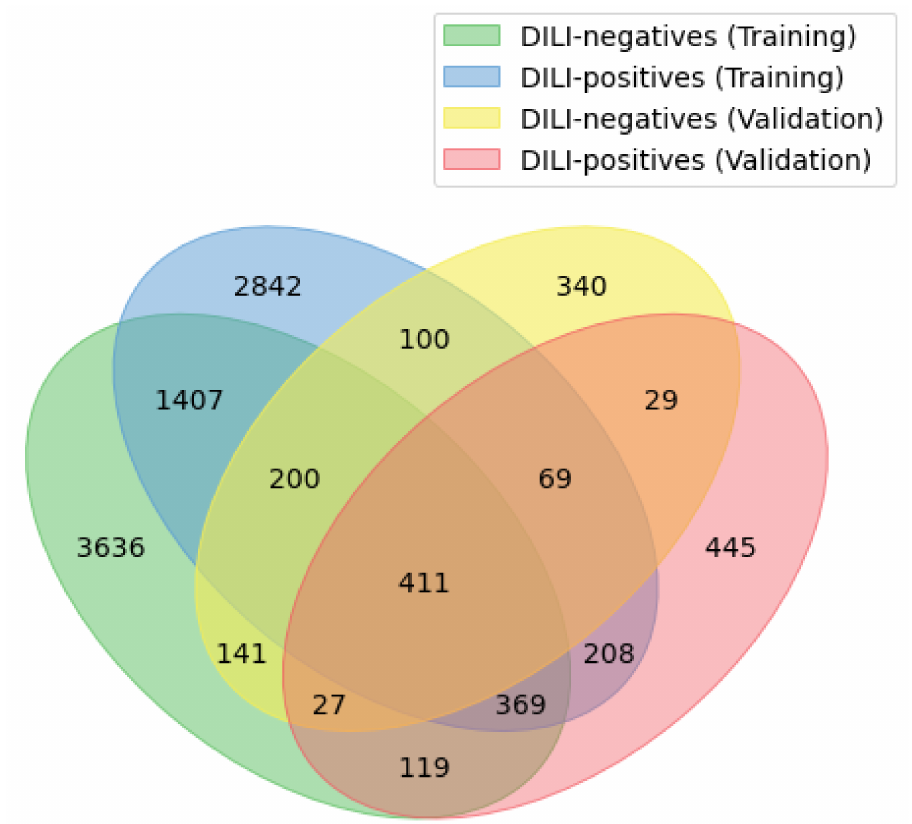
Figure 1. Venn diagram of unique integer ECFP4 fingerprint bits in the training data set and validation data